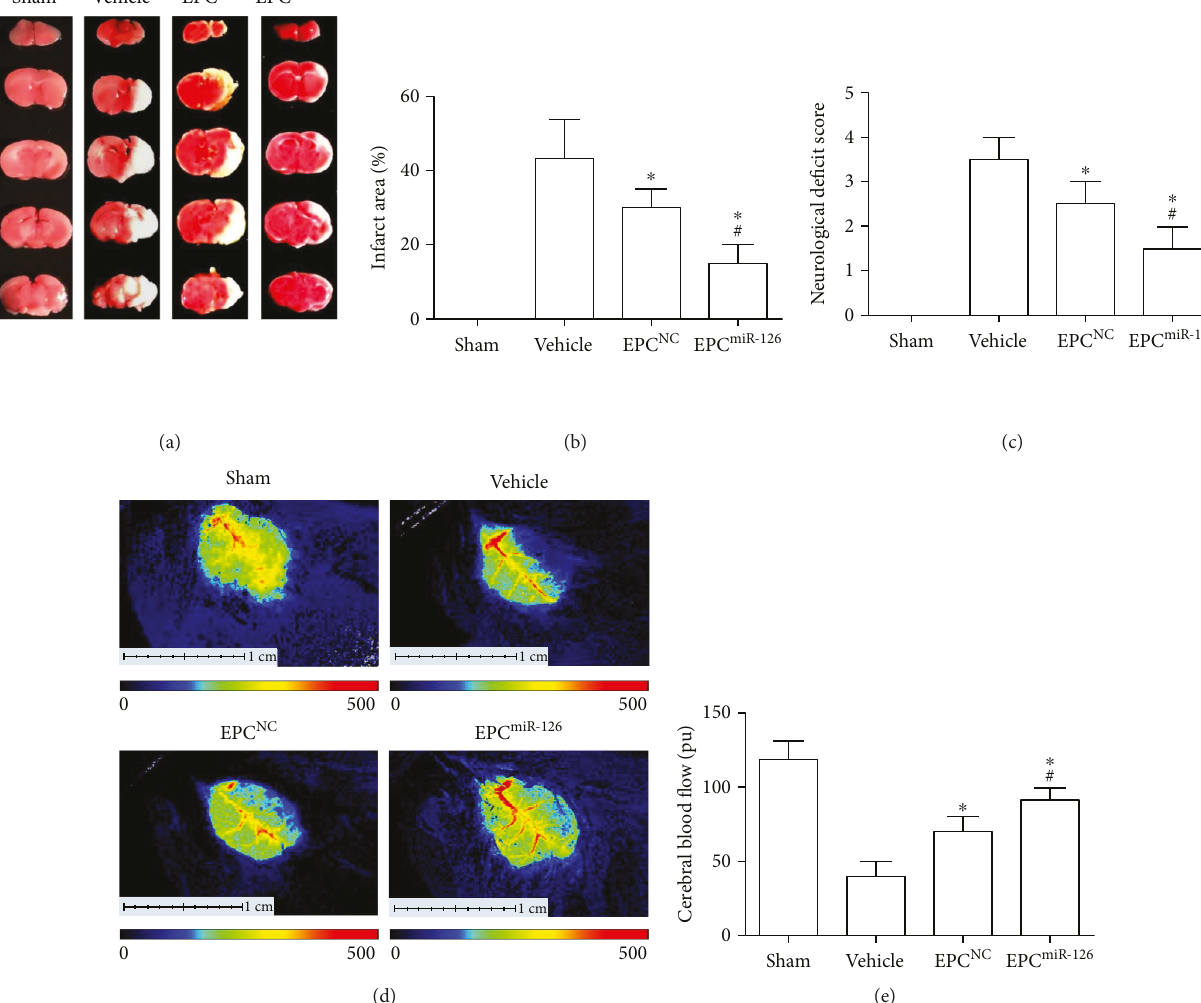
Figure 5: miR-126 priming enhances the e ffi cacy of EPCs in decreasing infarct area and NDS and improving CBF in MCAO mice. (a) Representative images of TTC staining. (b) Quantitative analysis of infarct size in di ff erent groups. (c) NDS in di ff erent groups. (d) The representative images of CBF. Blue to red represents low to high perfusion. (e) Summarized data on CBF. ∗ p < 0 05 versus vehicle; # p < 0 05 versus EPC NC , n = 10